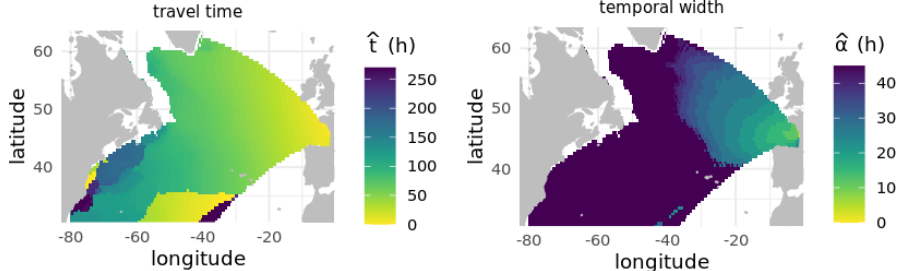
Figure 2. Estimated travel time (left). Estimated temporal width in hours (right; from Obakrim et al., 2022).